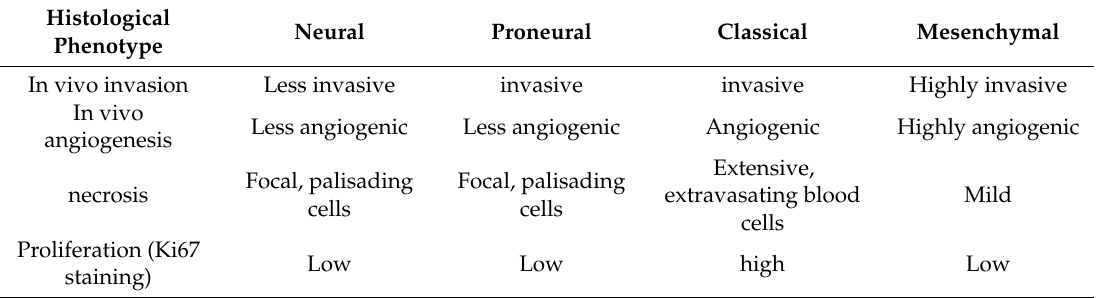
Figure 5. ( a ) The in vivo biological behavior of GIC subtypes was studied by orthotopic injection of cells into mouse brain. The neural xenograft subtype was the least angiogenic, as indicated by vWF staining. Ki67 staining showed that classical GICs were most active in proliferation in vivo. Scale bars: 100 µ m. ( b ) Neural GICs produced significantly lower amounts of VEGF and MMP-9. Table 2. The histological phenotypes of tumors formed di ff ered in relation to GIC